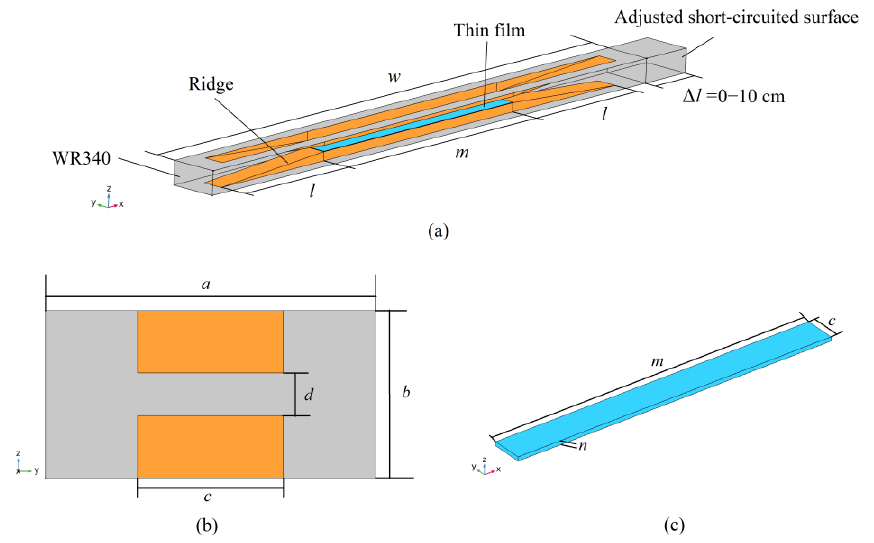
Figure 3. Geometry of 3D simulation model. ( a ) 3D geometry of the double-ridged waveguide; ( b ) The structure of the double-ridged waveguide in the y–z plane; ( c ) The thin film. Table 1. The detailed parameters of the double-ridged waveguide. (unit: mm).